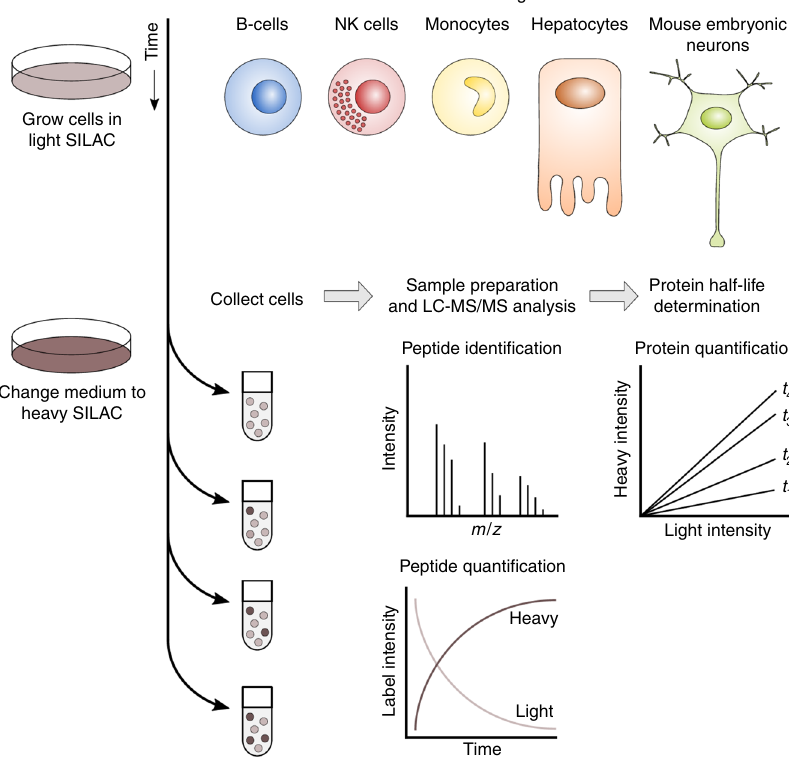
Fig. 1 Experimental work fl ow for protein half-life determination using dynamic SILAC and quantitative mass spectrometry. Five non-dividing primary cell types comprising B-cells, NK cells, monocytes, hepatocytes, and mouse embryonic neurons were adapted to light SILAC medium. To label newly synthesized proteins, the cells were exposed to heavy SILAC medium and collected at different time points. After protein extraction, proteolysis with trypsin, sample preparation, and subsequent LC-MS/MS analysis, the peptides were identi fi ed by the Mascot database search engine and quanti fi ed using the isobarQuant software package. Peptides of pre-existing and newly synthesized proteins were distinguished by their mass due to incorporation of light or heavy arginine and lysine. Protein fold changes at different time points were calculated using the intensity ratios of heavy vs. light SILAC peptides and were used for subsequent protein half-life